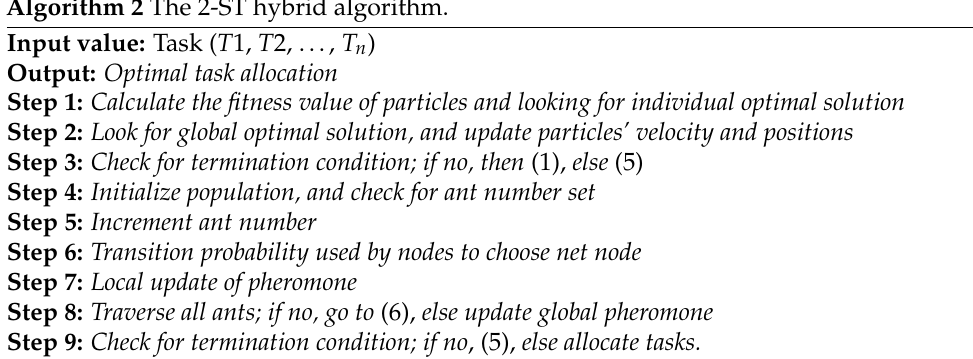
Algorithm 2 The 2-ST hybrid algorithm.